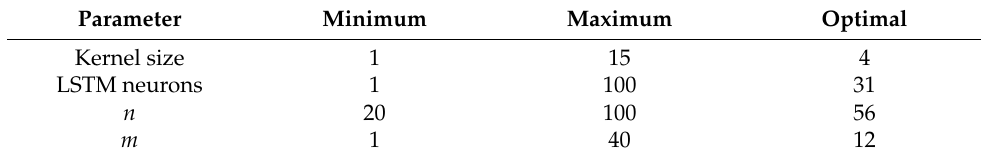
Table 1. Random search algorithm to set the parameters of the CNN-LSTM NN.